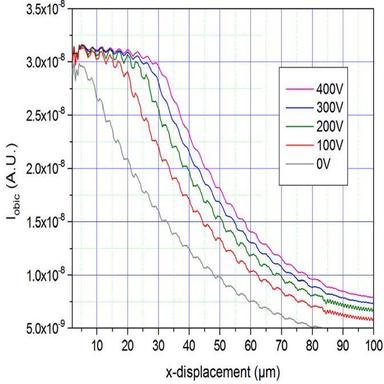
Distribution of OBIC current versus reduced x-position for different voltage (from 100 V up to 400 V).